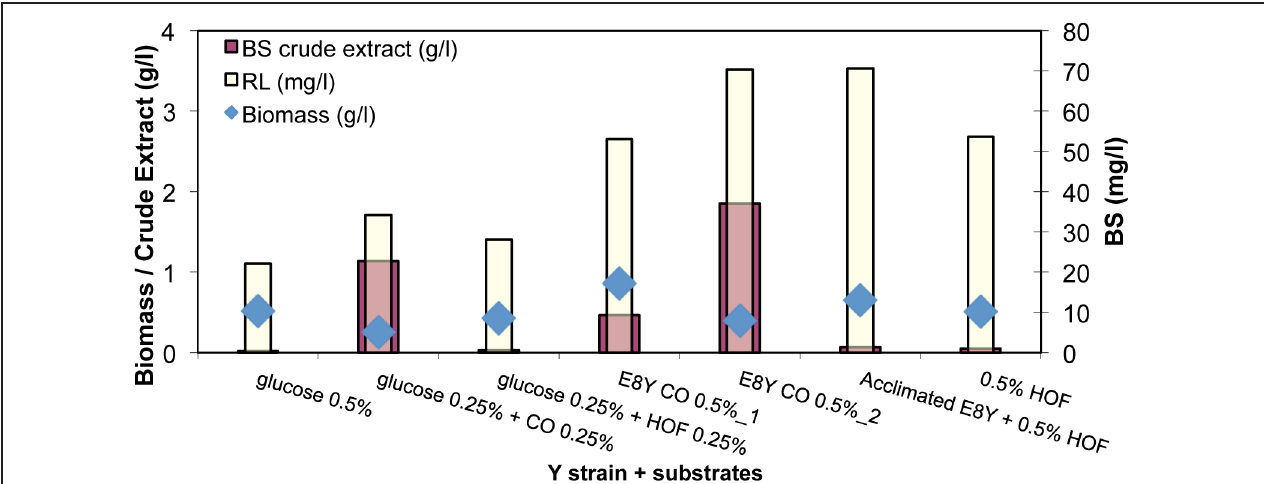
FIGURE 6 | Biomass (g/l), BS crude extract (g/l), purified RL (mg/l) concentration produced by the cultivation of strain E8Y for 12 days with substrates pure or mixtures of glucose, crude oil (CO), and heavy oil fraction (HOF). In sample E8Y CO 0.5% wt_1 BS was extracted by the culture without the oil phase. In sample E8Y CO 0.5% wt_2 BS was extracted by the whole culture.